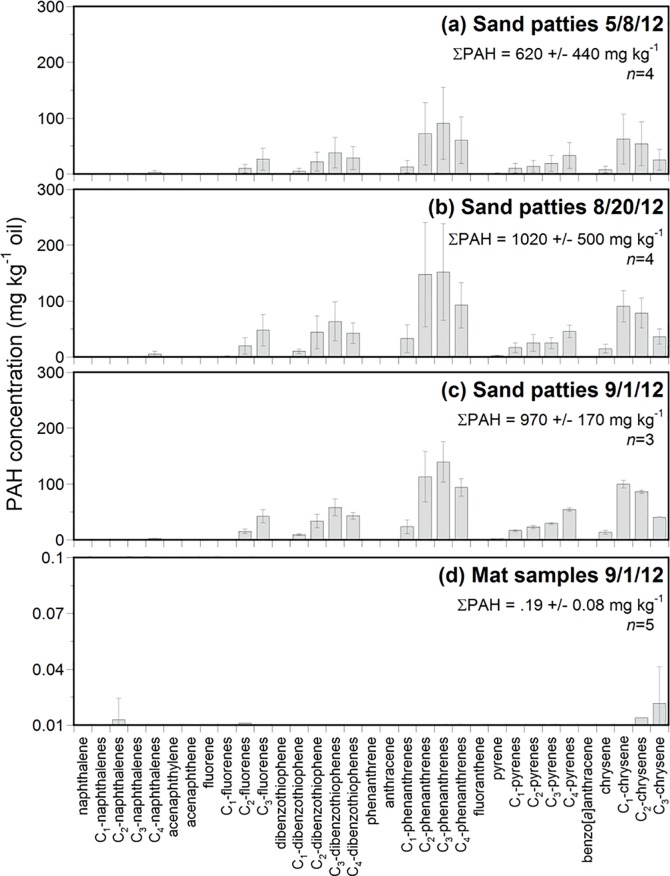
PAH content.Polycyclic aromatic hydrocarbon (PAH) content normalized to total extractable material for (a) MW oil and (b-d) average values for sand patty and mat samples collected following Hurricane Isaac. Collection date, total PAH (ΣPAH) content and number of samples (n) contributing to average values are indicated for each plot. Sample details for each date can be found in Table 1.